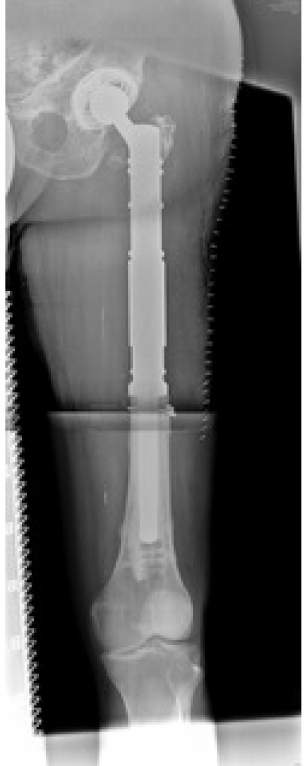
Figure 2. This X-ray (.-p. view) shows the status 13 months after resection of the proximal femur (former metastasis) and curettage of the distal part (intralesional procedure, histopathologically no tumor vitality after saturated initial irradiation). The Karnofsky index was 80% and the Musculoskeletal Tumor Society score (MSTS score) was 90% at the last follow up. The patient is still